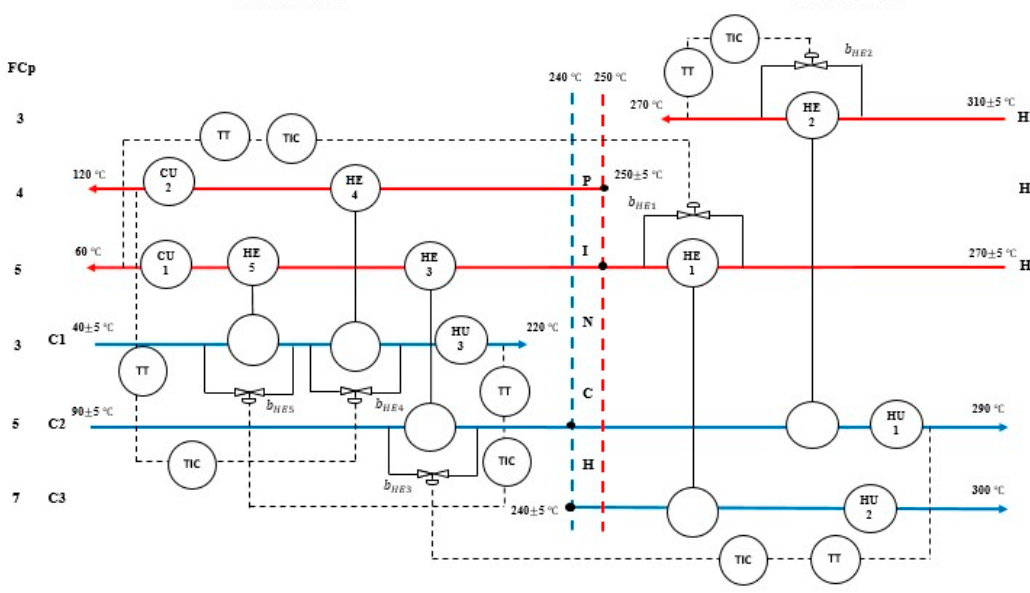
Figure 17. Overall HEN with bypass placement. 12